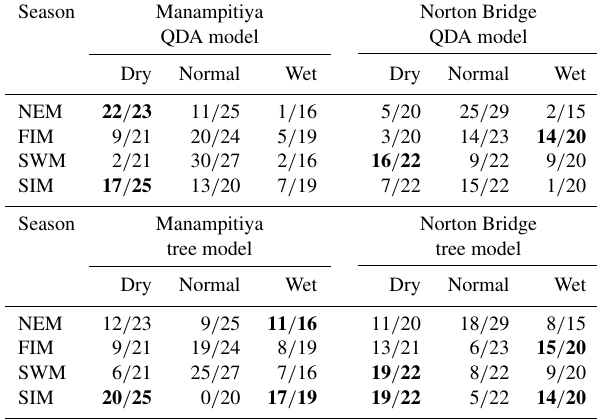
Table 2. Classification model results. Bold cells indicate where there may be information content with respect to forecasting either dry or wet anomaly classes as judged by a classification success rate of at least